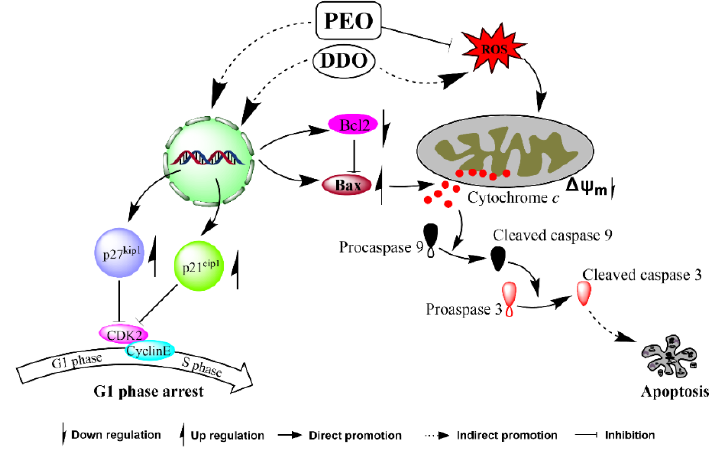
Figure 12. The possible mechanisms for PEO- and DDO-induced G1 phase arrest through upregu- lating p21 cip1 and p27 kip1 signaling and apoptosis via mitochondria-dependent pathway in A549 cells.